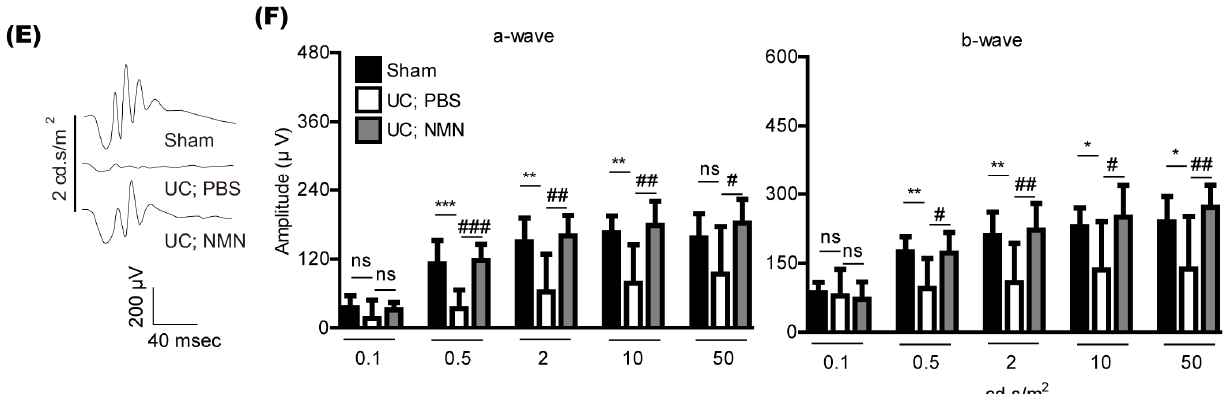
Figure 1. Retinal functional protection by continuous NMN treatment. ( A ) A general experimental scheme. UCCAO, unilateral common carotid artery occlusion; D, day; ERG, electroretinography; i.p., intraperitoneal injection; NMN, nicotinamide mononucleotide. ( B ) An anatomical view on the